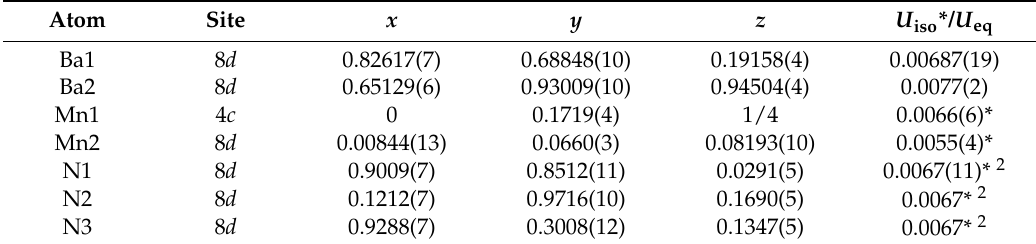
Table 2. Atomic Positions and Isotropic (Equivalent) Displacement Parameters (Å 2 ) for Ba 4 [Mn 3 N 6 ] 1 .